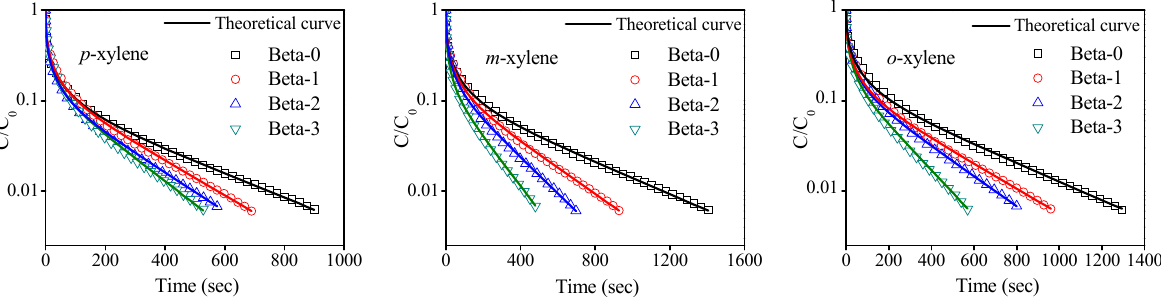
Figure 5. Experimental data (symbols) and theoretical ZLC curves (lines) for xylene isomers in Beta zeolite samples at 373